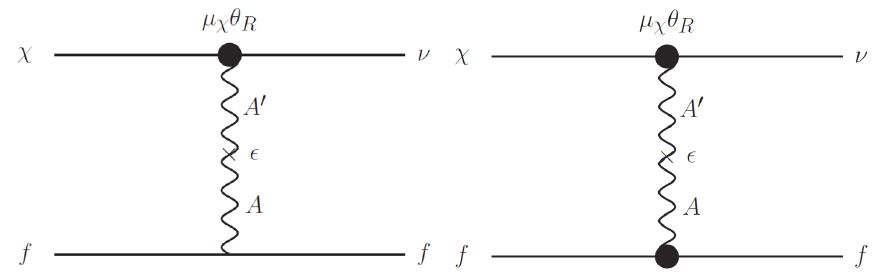
Figure 1 . Diagrams for DM absorption from dipole-charge (left) or dipole-dipole (right) interaction in our model. The black dot denotes the magnetic dipole